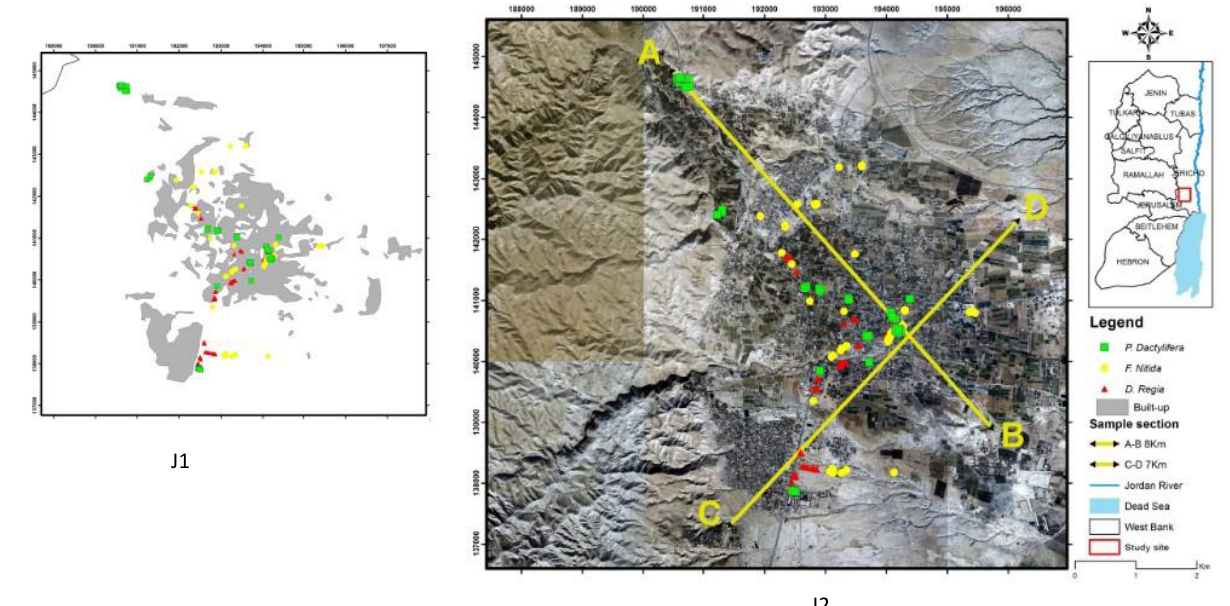
Figure 1. Spatial distribution of the measuring site following a north–south and east–west transect within Jericho. ( J1 ) shows the distribution of the selected urban trees along the transects encompassing the urban area. ( J2 ) shows an aerial image of the boundaries of Jericho, depicting the northwest–southeast transect (A,B) with a length of 7 km and the southwest–northeast transect (C,D) with a width of 5 km. Table 1. The number of measured tree species for four different planting categories: public space, parking lot, street, and